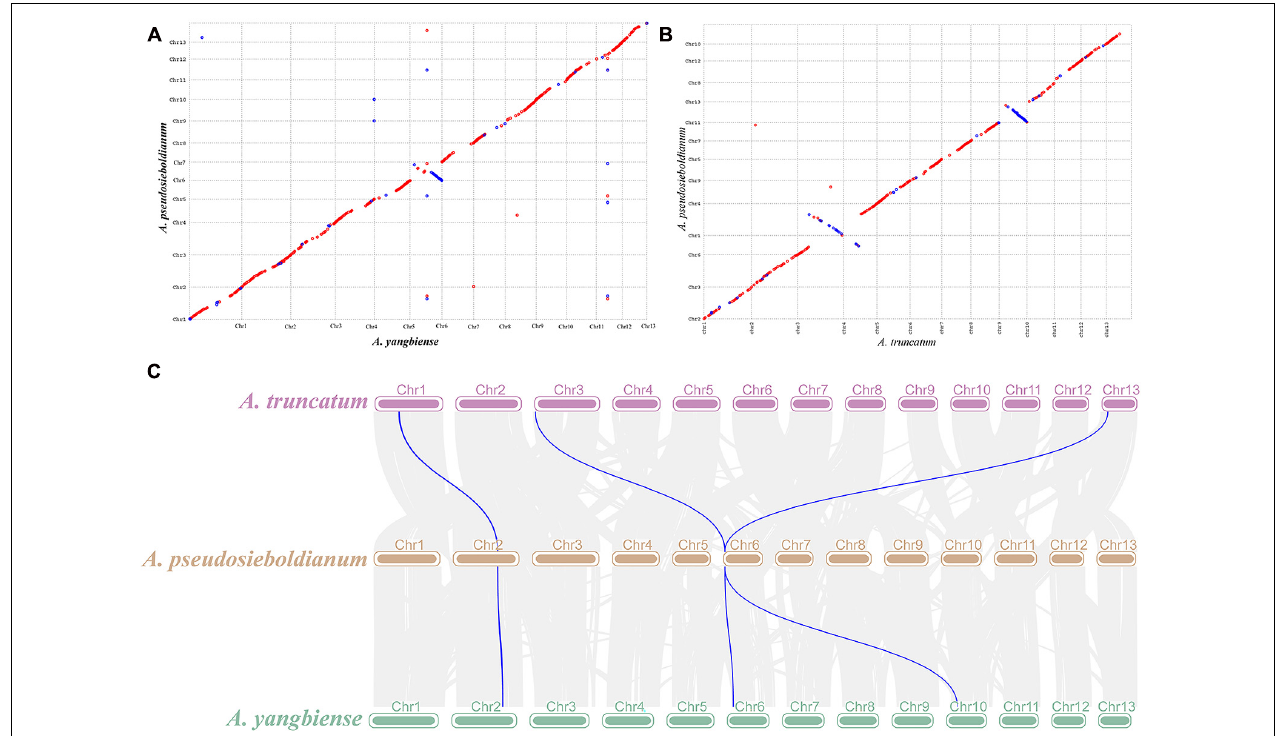
FIGURE 4 | Synteny analysis of A. pseudosieboldianum , A. yangbiense and A. truncatum . (A) Dot plots of syntenic blocks between A. pseudosieboldianum and A. yangbiense . (B) Dot plots of syntenic blocks between A. pseudosieboldianum and A. truncatum . The red line represents sequence forward matching, and the blue line represents reverse complementary matching. (C) Blocks with syntenic genes among A. pseudosieboldianum , A. yangbiense, and A. truncatum . The blue line shows an example of two syntenic